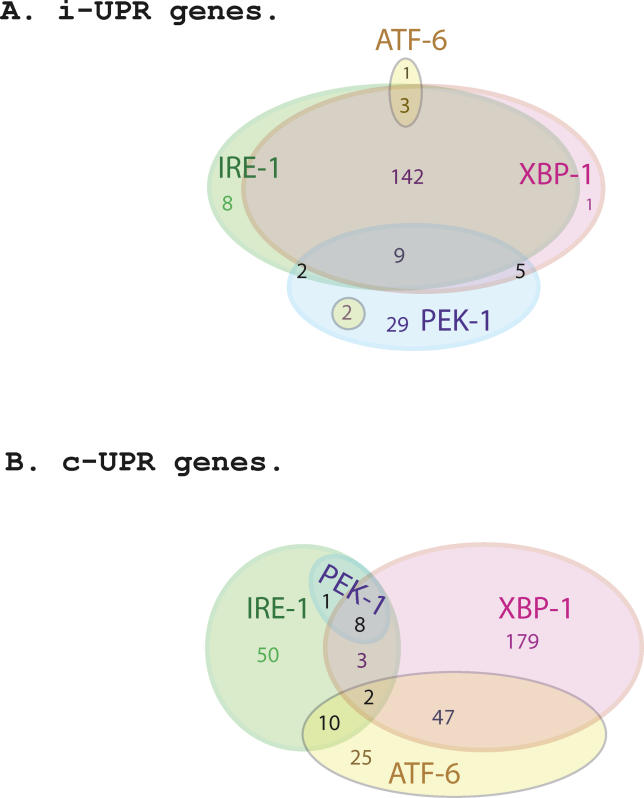
Transcriptional Targets of ire-1, xbp-1, pek-1, and atf-6
(A) Venn diagram showing the sets of i-UPR genes regulated by ire-1, xbp-1, pek-1, and atf-6.(B) Venn diagram showing the sets of c-UPR genes regulated by ire-1, xbp-1, pek-1, and atf-6.